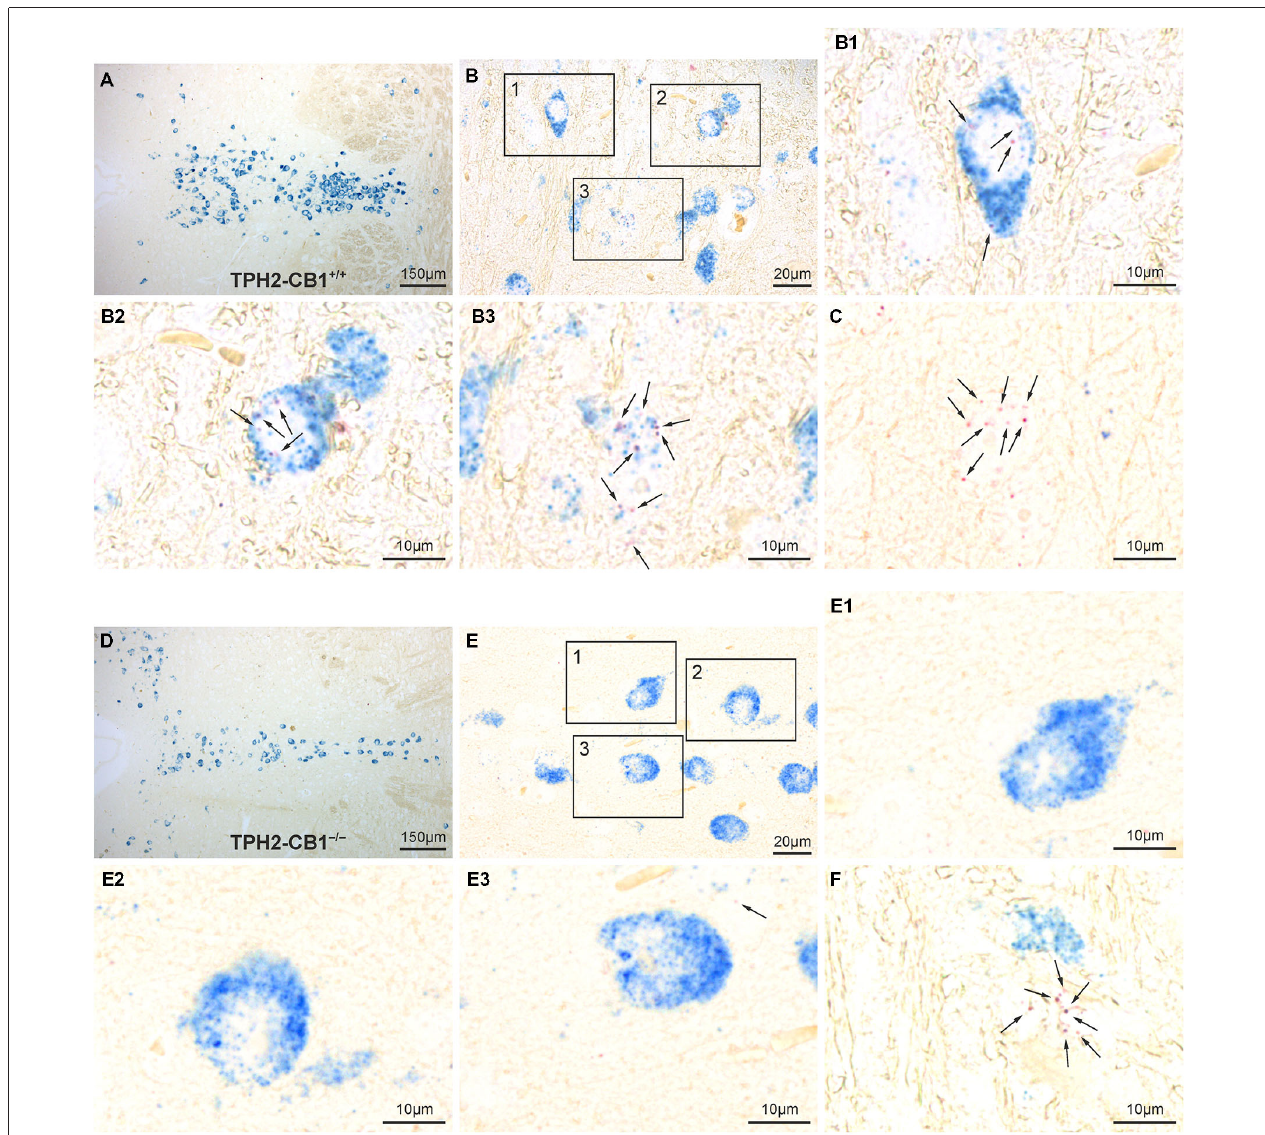
FIGURE 2 | Verification of 5-hydroxytryptamine (5-HT) neuron-specific CB 1 loss by in situ hybridization (ISH). (A,D) Overview of the dorsal raphe nucleus (DRN) double-stained for CB 1 (red staining) and TPH2 (blue staining) in TPH2-CB 1 + / + (A) and TPH2-CB 1 − / − (D) mice. TPH2 probes were used to define serotonergic neurons. (B,E) Higher magnification of coronal hindbrain sections showing presence or absence of CB 1 mRNA in serotonergic neurons in TPH2-CB 1 + / + (B) and TPH2-CB 1 − / − (E) mice. Note that the low expression levels of CB 1 (2–7 red dots in a cross-section of a serotonergic neuron) make visualization of coexpression possible only at high magnification (see inserts). In TPH2-CB 1 − / − mice, less than 1 in 100 serotonergic cell expressed CB 1 . (B 1 –B 3 ) Serotonergic neurons expressing CB 1 mRNA and (C) a CB 1 -positive, non-serotonergic neuron in TPH2-CB 1 + / + . (E 1 –E 3 ) Serotonergic neurons are devoid of CB 1 mRNA in TPH2-CB 1 − / − mice, but CB 1 -positive, TPH2 -negative neurons (F) are still present. Arrows, Fast Red alkaline phosphatase substrate, representing CB 1 mRNA